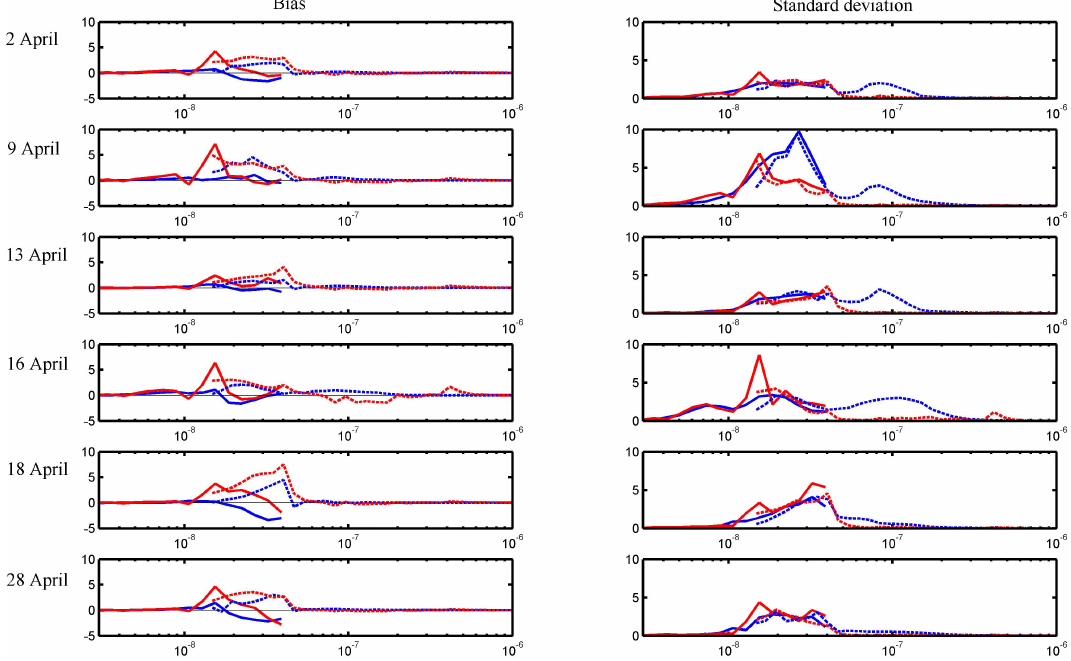
Fig. 6. The bias and standard deviation of x EKF (blue) and x INV (red) as compared to the raw measurements from DMPS I (solid) and II (dashes) for 6 days in April. The bias and standard deviation are on the y-axis [cm − 3 ] and particle diameter on the x-axis [m]. Note that the results are presented for the characteristic